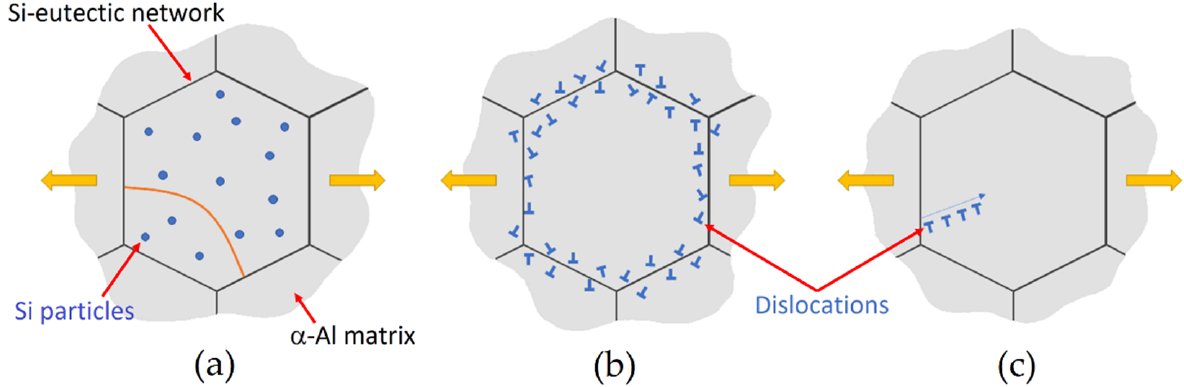
Figure 13. Graphical representation of the interaction between the dislocations and: ( a ) the Si particles within the α -Al matrix, and ( b , c ) the Si-eutectic network (Reprinted from reference